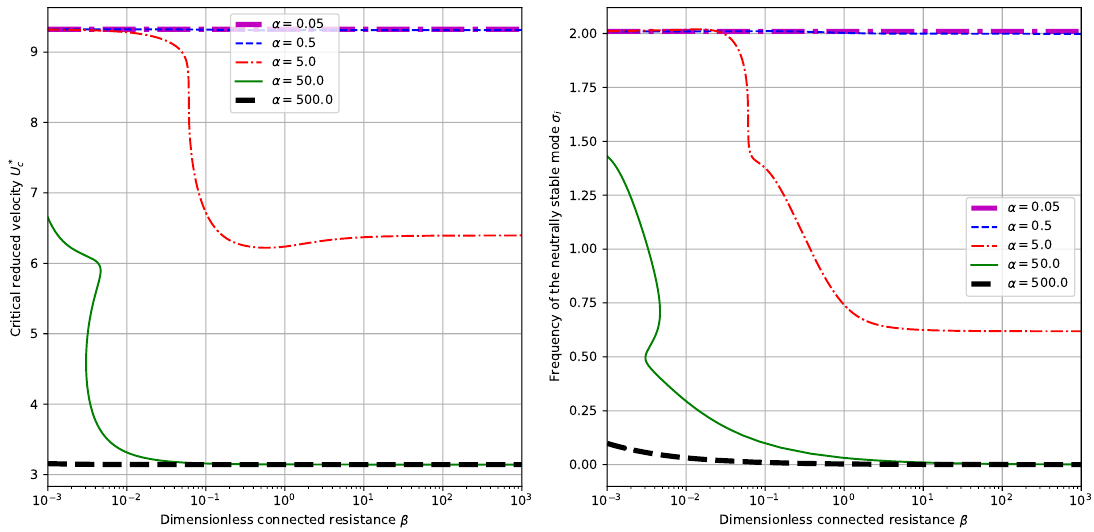
Figure 8. Dependence of critical reduced velocity U ∗ c and neutrally stable frequency σ i upon the externally connected resistance β and different values of α . (Here we have M ∗ =